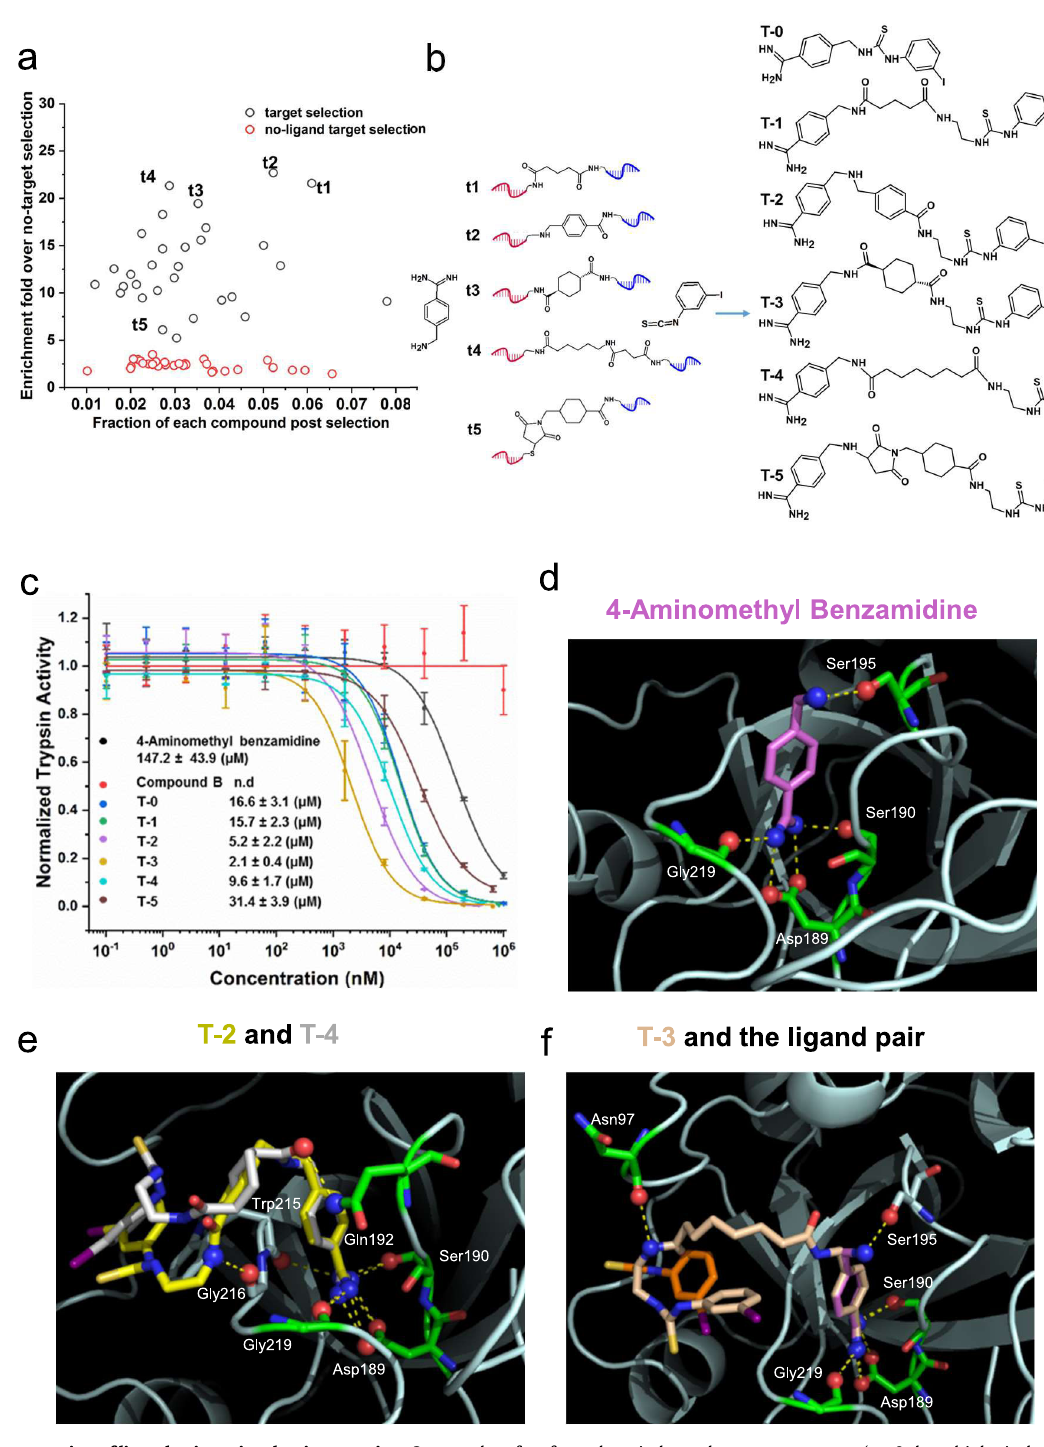
from three independent measurements ( n =3 three biological replicates). n.d: not detected d – f Dockingposeof4-aminomethylbenzamidine,superimposedposesof T-2andT-4,andthedockingposeofT-3andtheligandpairincomplexwithbovine trypsin (PDB: “ 1BTY ” ). Compound B is orange, and 4-aminomethyl benzamidine is magenta. The protein is in cartoon style, certain residues, and the compounds are in stick representation, and the hydrogen bond-forming atoms are in ball repre- sentation. Yellow dashed lines indicate hydrogen bonds. Source data are provided as a Source Data fi